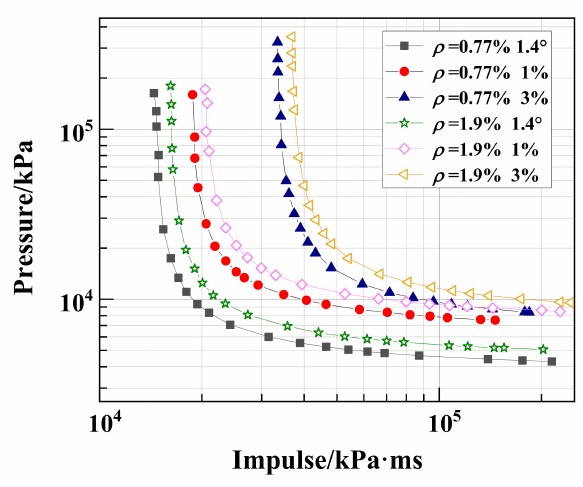
Figure 20. Analysis of P-I curves with two longitudinal reinforcement rates, 0.77% and 1.9%.